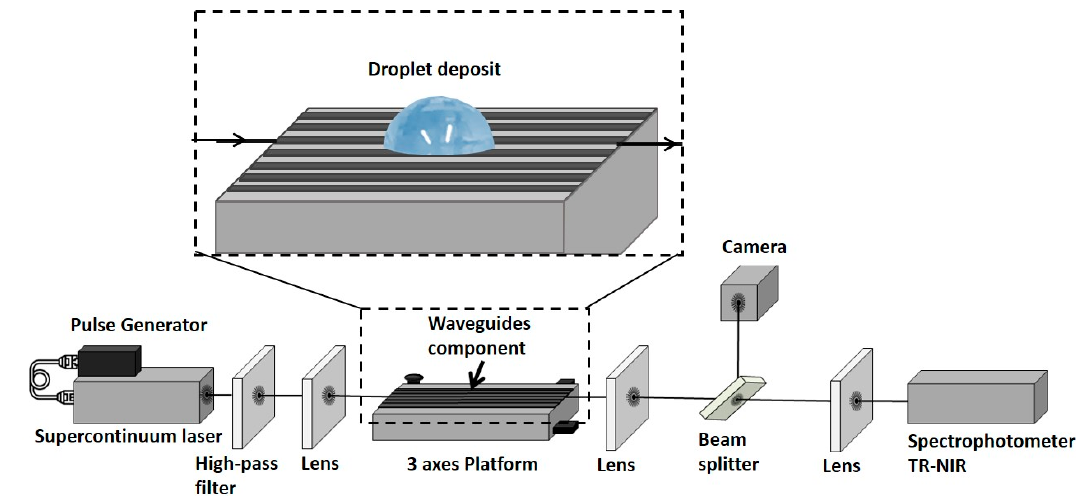
Figure 1. Spectrophotometric bench used to characterize droplet deposits onto the rib waveguide surface. Zoom on the component to visualize the droplet deposited on the top to perform the tests.